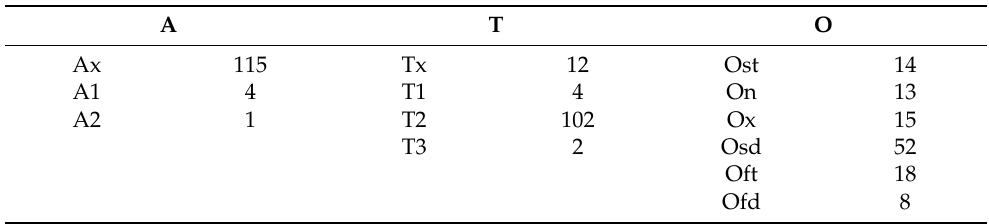
Table 2. Occurrence of individual types of tympanoplasty in the group of 92 patients (120 ears) according to the ATO